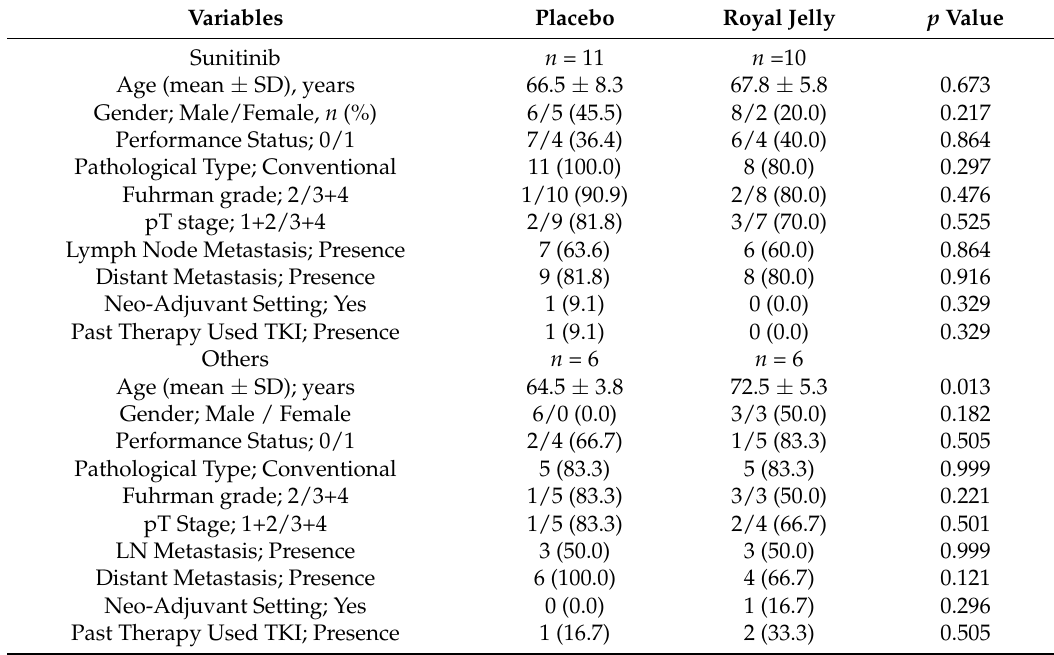
Table 2. Clinicopathological features and basic characteristics according to used